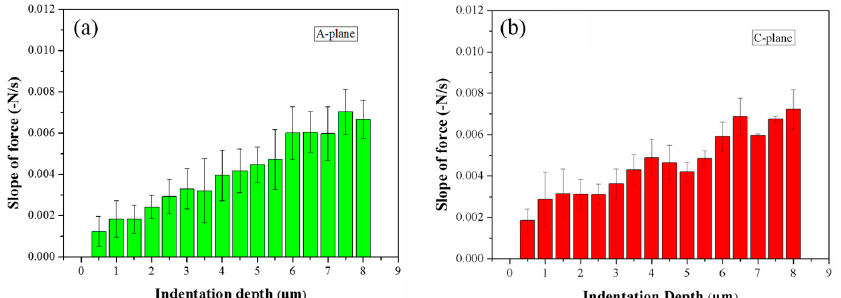
Figure 5. The slope of the force decline during each dwell period of the loading stage corresponding to a series of indentation depths for ( a ) A-plane and ( b ) C-plane sapphire (indentation depth 8 µ m, dwell period 10 s).